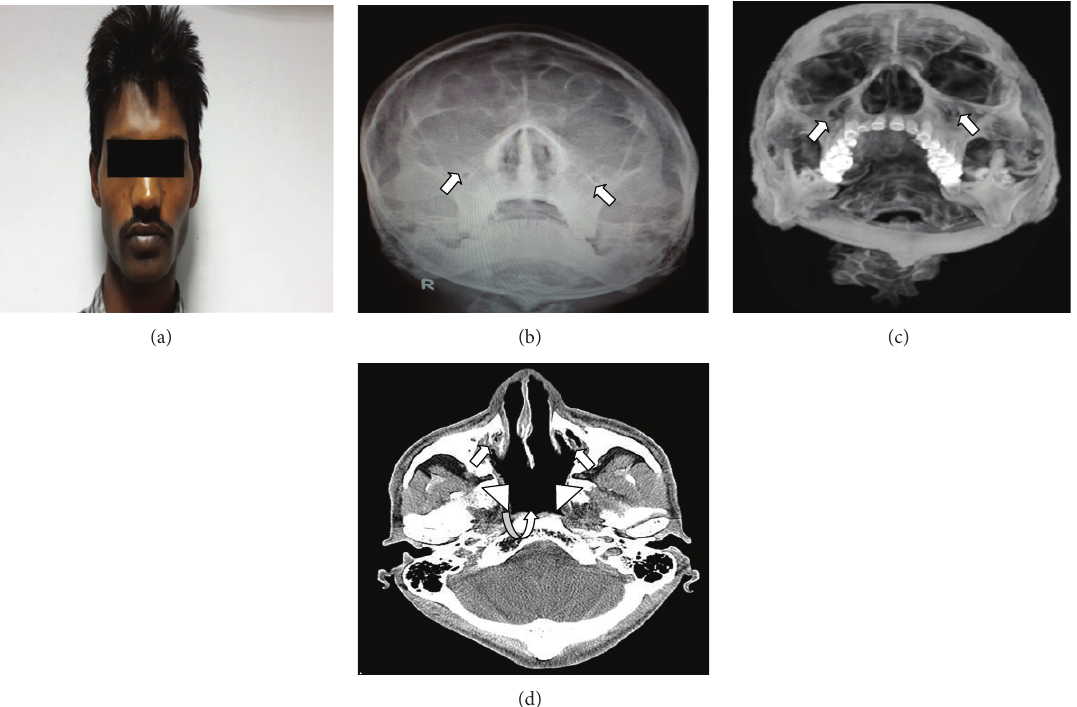
Figure 1: 25-year-old male with recurrent headache. Face profile of patient (a). Opacification of bilateral maxillary sinuses (arrow) on plain radiograph (b) with loss of pneumatisation (arrow) on 3D CT reconstruction paranasal sinuses (c). Cleft like bilateral maxillary sinuses (arrow) and absent uncinate process (arrowhead) and enlargement of nasal fossa (curved arrow) on axial section plain CT paranasal sinuses (d).